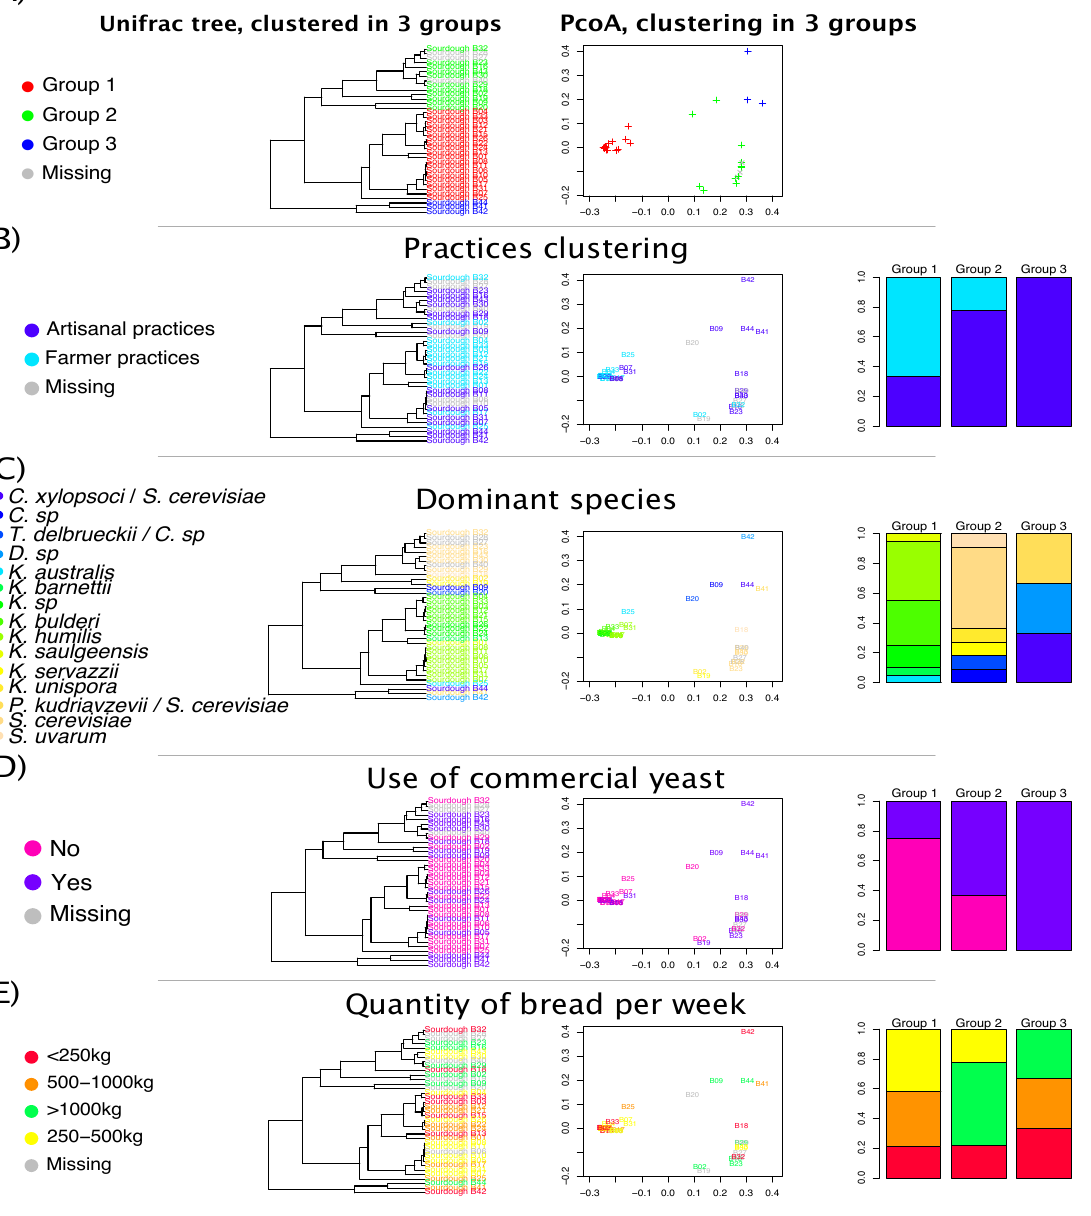
Figure 5: Clustering of sourdough fungal communities based on weighted UniFrac distances and association with baking practices. The weighted UniFrac distance between communities takes into account the relative abundance of the observed species as well as their phylogenetic relationships. In all panels, the clustering of sourdoughs fungal communities based on their Unifrac distances is shown on a tree on the left and on a Principal Component Analysis (PcoA) in the center. Panel A shows the three groups of fungal communities formed based on their weighted UniFrac distances. Panels B through E highlight the distribution of a principal variable in these three groups of fungal communities. The distribution is shown by coloring the different levels of the variable on the tree and on the PCoA but also as a barplot on the right side of the panel. Panel B shows the distribution of the two types of bread making practices, panel C the dominant yeast species, panel D the use of a commercial yeast starter, panel E the amount of bread made each week. Group 1 contains sourdough fungal communities whose dominant species is a Kazachstania species. Group 2 contains sourdough fungal communities whose dominant species is Saccharomyces cerevisiae . Group 3 contains sourdough fungal communities in which two yeast species co-occurred, one being S. cerevisiae . The yeast genus in panel C is abbreviated with, C. for Candida , D. for Dipodascaceae , K. for Kazachstania , S. for Saccharomyces , T. for